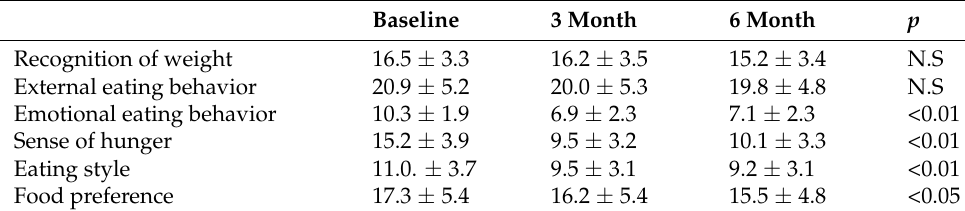
Table 2. Basal and time-course changes in eating